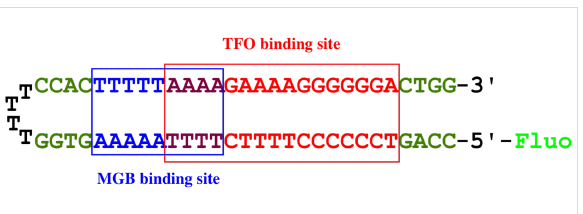
Figure 4: The target duplex contains a 29 base pair fragment from HIV proviral DNA [35] and a T4 hairpin is connecting two strands: a 16 base pair polypurine-polypyrimidine tract (TFO-binding site – is indicat- ed by a red rectangle), an adjacent overlapping poly(dA:dT) tract (MGB-binding site – by a blue rectangle). Fluo is a fluorescein